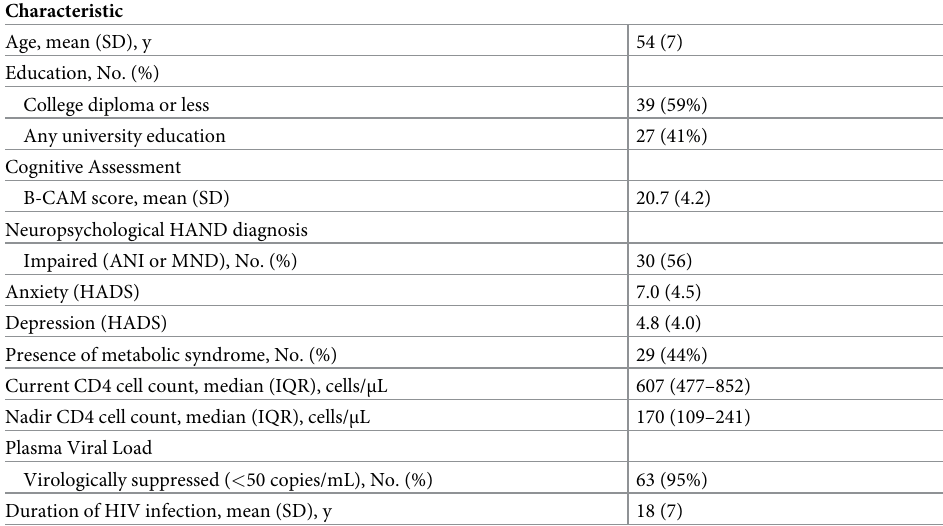
Table 1. Demographic, clinical, and neuropsychological characteristics of the participants(N = 66). Characteristic